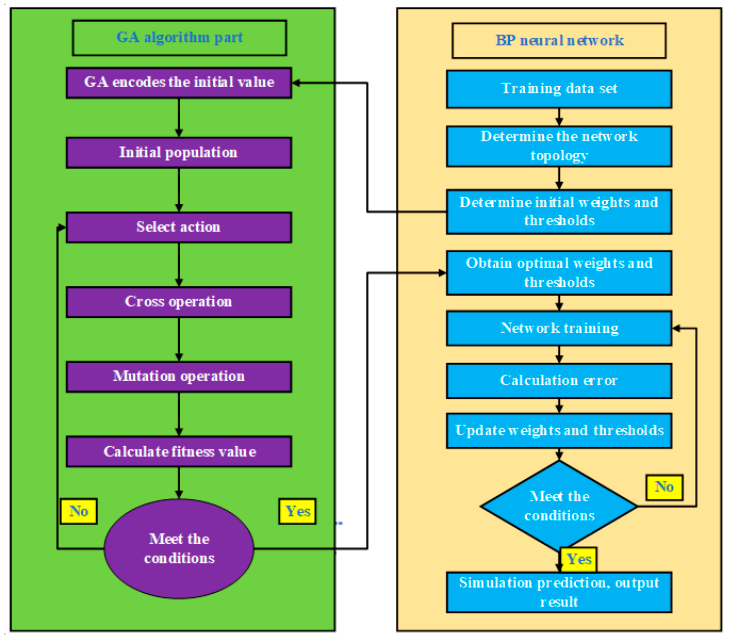
Figure 4. GA-BP model calculation process.